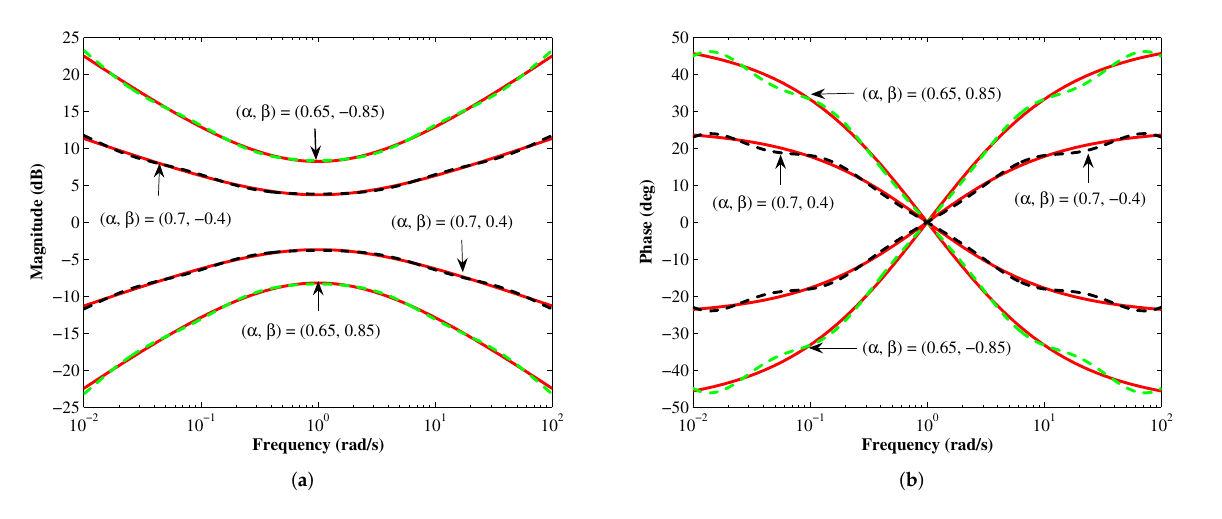
Figure 7. ( a ) Magnitude and ( b ) phase responses of the proposed FBPFs and FIBPFs for N = 4. The theoretical response is shown in solid red. Table 7. Performance indices of the designed FBPFs for different values of N